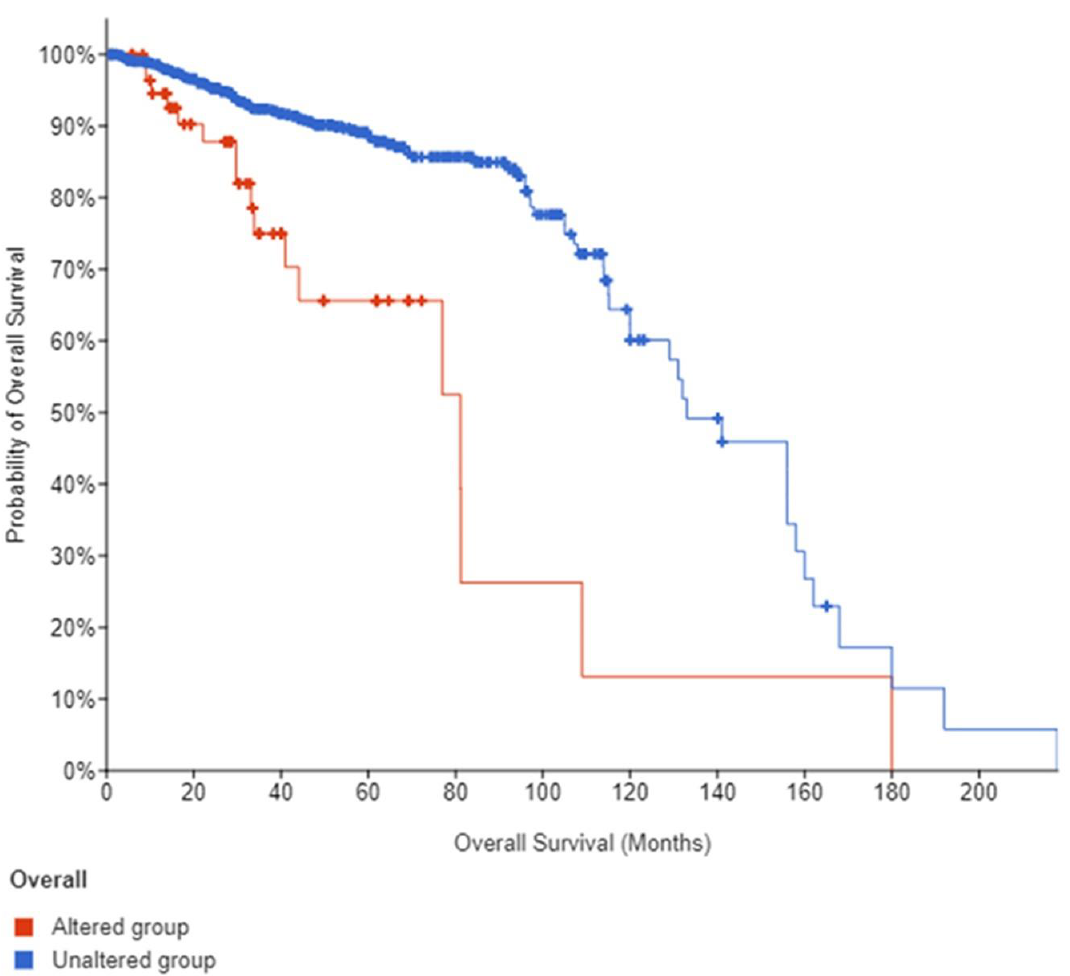
Figure 9. Overall survival